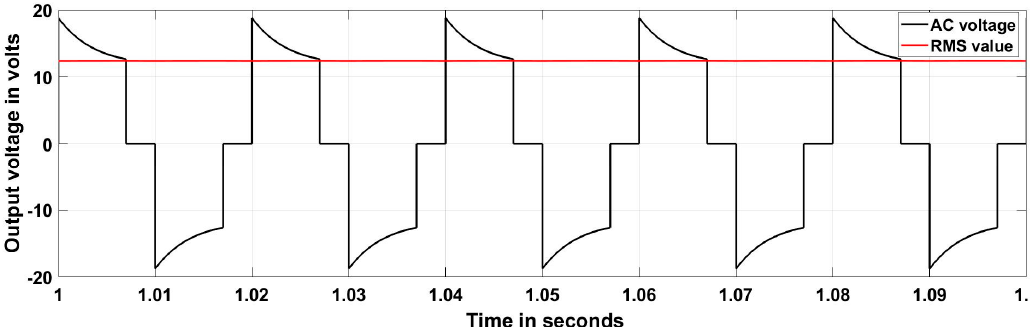
Figure 19. Simulated output of output voltage for inverter in boost mode.